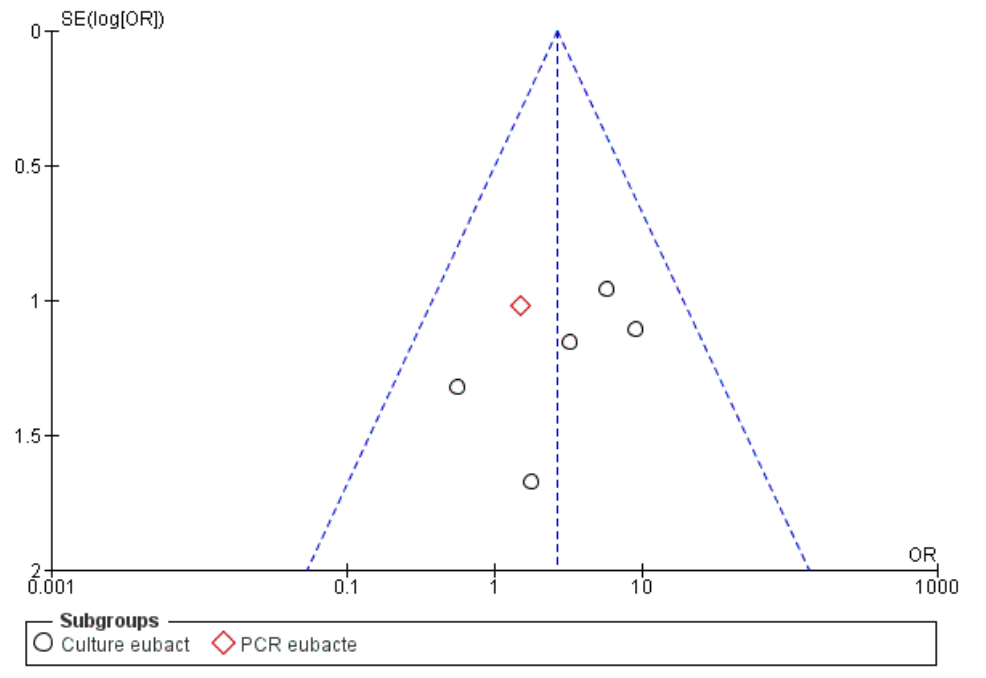
Figure 6. Funnel plot for the sub-group Eubacterium, I 2 = 0%. Sub-group culture I 2 = 0%. The heterogeneity between the two sub-groups is I 2 = 0%.